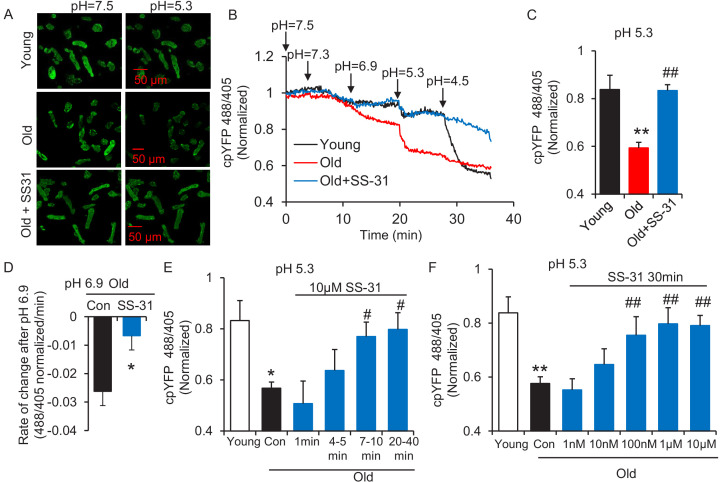
SS-31 restores the resistance of cardiomyocytes from old rat to proton entry into the mitochondrial matrix during external pH gradient stress.(A) Typical image of the effects of pH gradient stress on permeabilized rat cardiomyocyte mt-cpYFP fluorescence. Upper panel, young, middle panel, old, lower panel, old+SS-31 (10 μM, 3 days) visualized after exposure of the cells to pH 7.5 and, later, to pH 5.3. The excitation is 488 nm and collection is at 505–730 nm. (B) Saponin (50 μg/ml) permeabilized cardiomyocytes expressing mt-cpYFP were exposed to progressively lower external pH. Proton permeability of old mitochondria was greater than that of young mitochondria, but preincubation of old cells with 10 μM SS-31 for 3 days enhanced the mitochondrial inner membrane resistance to the pH stress. The traces were averaged from 4 to 19 experiments. The arrows indicate the changes of pH. (C) Quantitation of the SS-31 treatment effect on the mitochondrial matrix cpYFP ratio at pH 5.3. The data are from 7 to 8 min after the pH was adjusted to 5.3. The mean value of the normalized 488/405 ratio in old group is 0.59 with a SD ±0.10 and the range is from 0.46 to 0.77. N = 5–19 rats in each group, analyzed by one-way ANOVA with Dunnett’s test. (D) SS-31 decreased the rate of cpYFP 488/405 ratio drop at pH 6.9. N = 4–10 rats in each group. The rate is calculated as indicated in Figure 2—figure supplement 3. Student’s t-test was applied to determine the statistical significance. The time dependence (N = 3–4 rats in each group) (E) and dose dependence (N = 3–14 rats in each group) (F) of SS-31 protection of mitochondrial resistance to pH gradient stress are shown and analyzed by one-way ANOVA with Fisher’s LSD test. After cardiomyocyte permeabilization, 10 μM SS-31 was added for the times shown in (E) or at the doses shown in (F) for 30 min, followed by pH stress. *p<0.05, **p<0.01 vs Young; #p<0.05, ##p<0.01 vs Old.